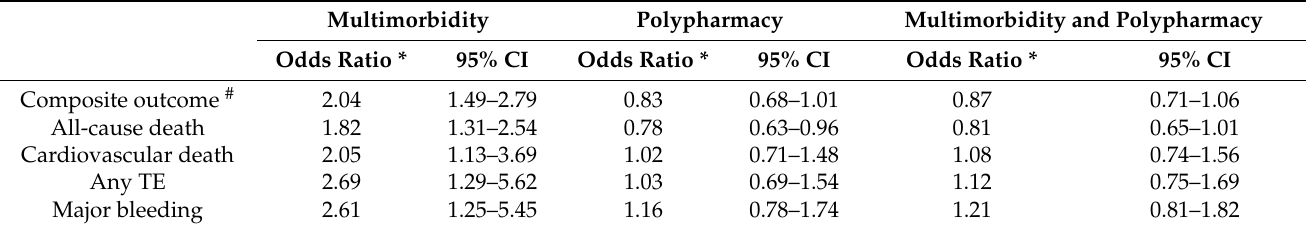
Table 2. The effects of multimorbidity and polypharmacy on clinical outcomes (composite outcome; all-cause death; cardiovascular death; any thromboembolism; major